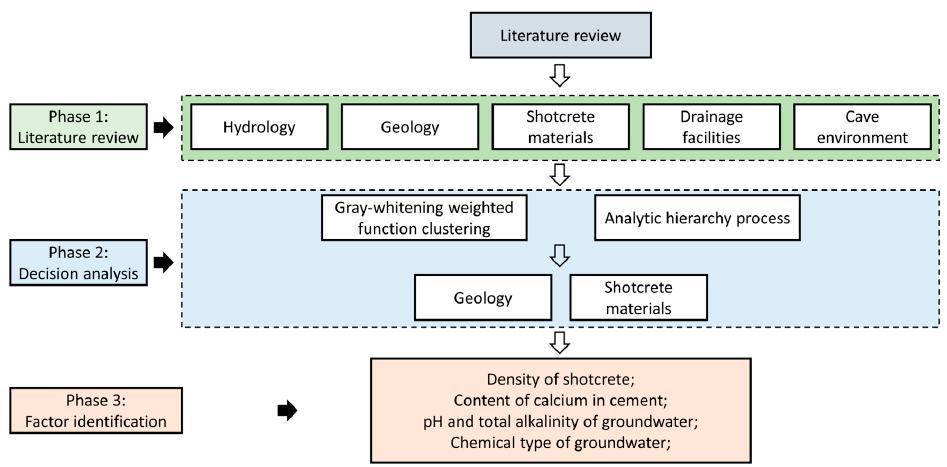
Figure 1. Flowchart of research methodology of this study.